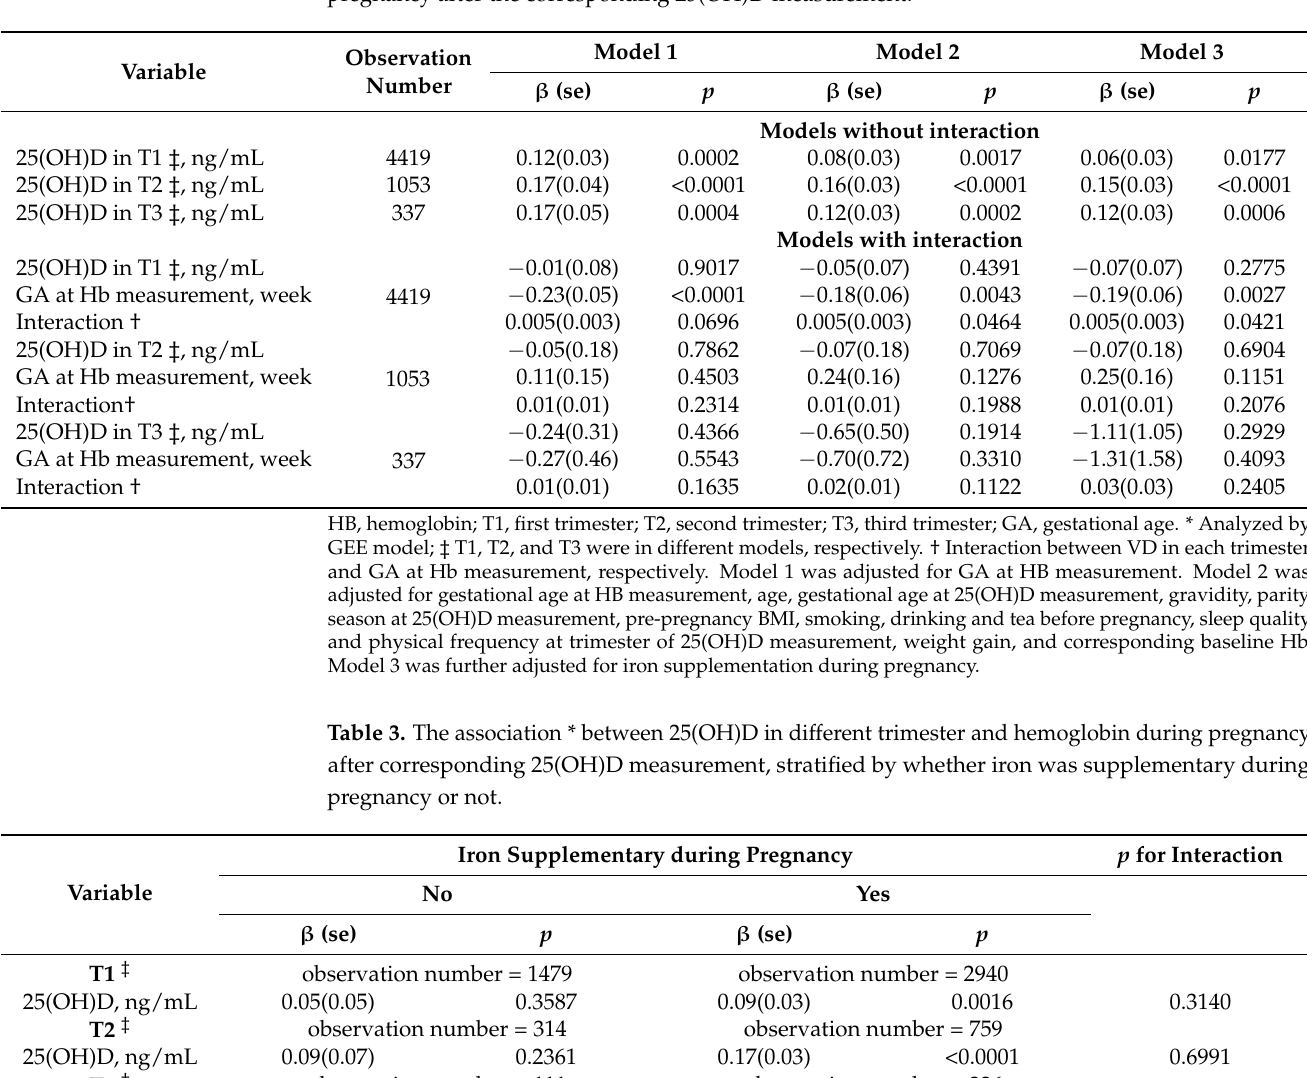
Table 2. The association * between plasma 25(OH)D in different trimesters and hemoglobin during pregnancy after the corresponding 25(OH)D measurement.